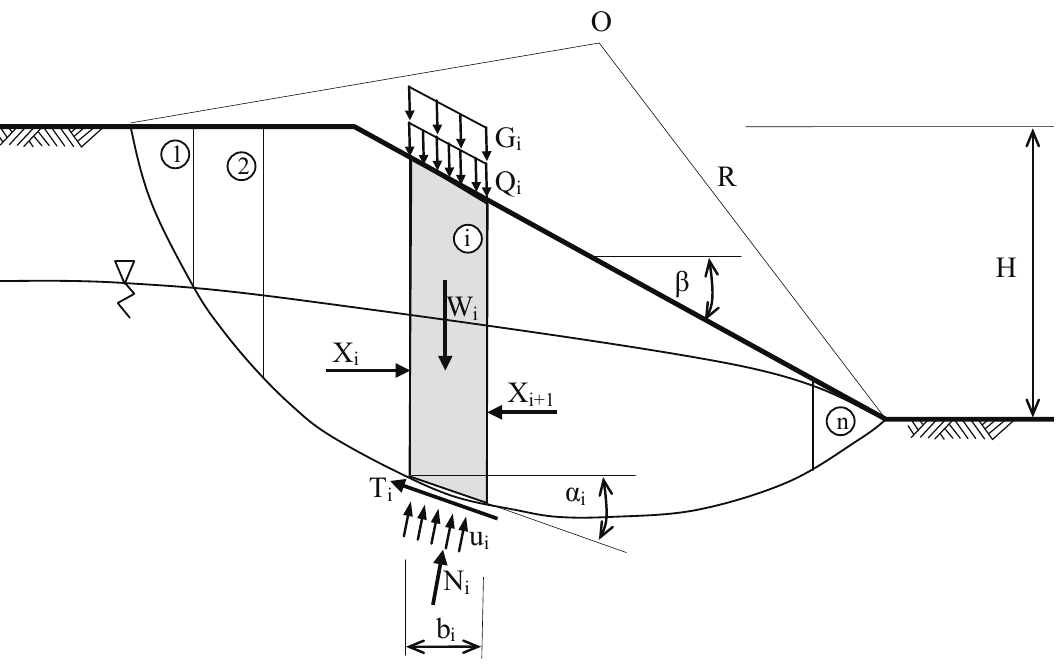
Figure 1: Scheme of the Bishop method